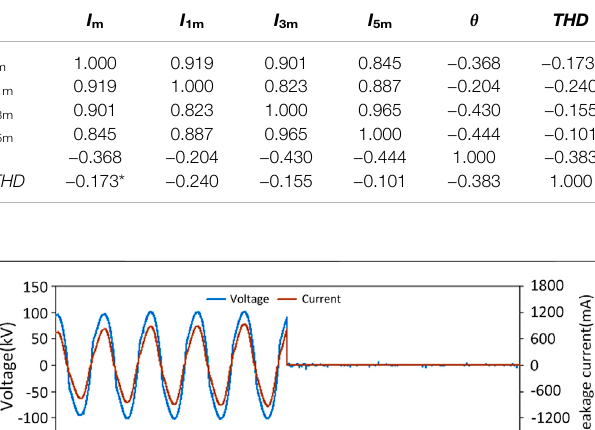
TABLE 5 | The coef fi cient of LC eigenvalues ( ESDD (cid:2) 0.4 mg/cm 2 ).